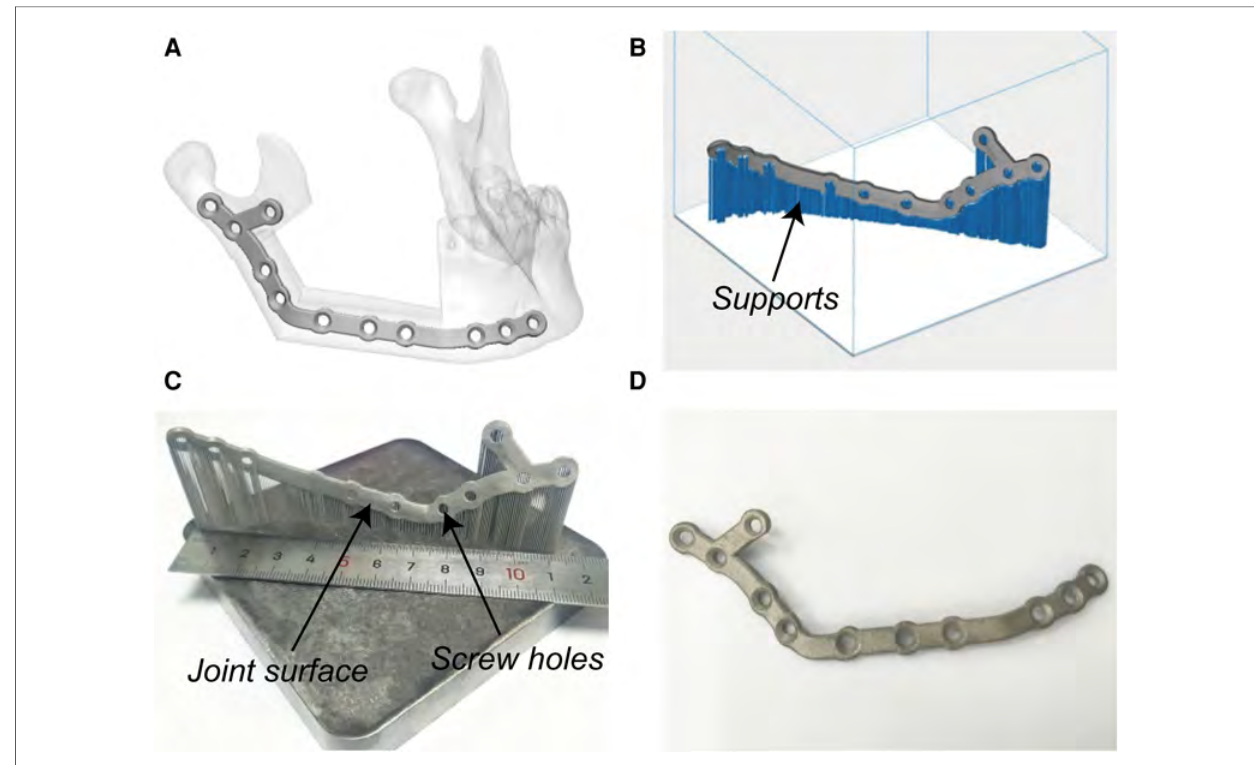
FIGURE 3 Virtual designing and additive manufacturing of PSSPs. (A) Virtual PSSPs. (B) Design supports. (C) Printed PSSPs with reasonable joint surface and screw holes. (D) Post-processed